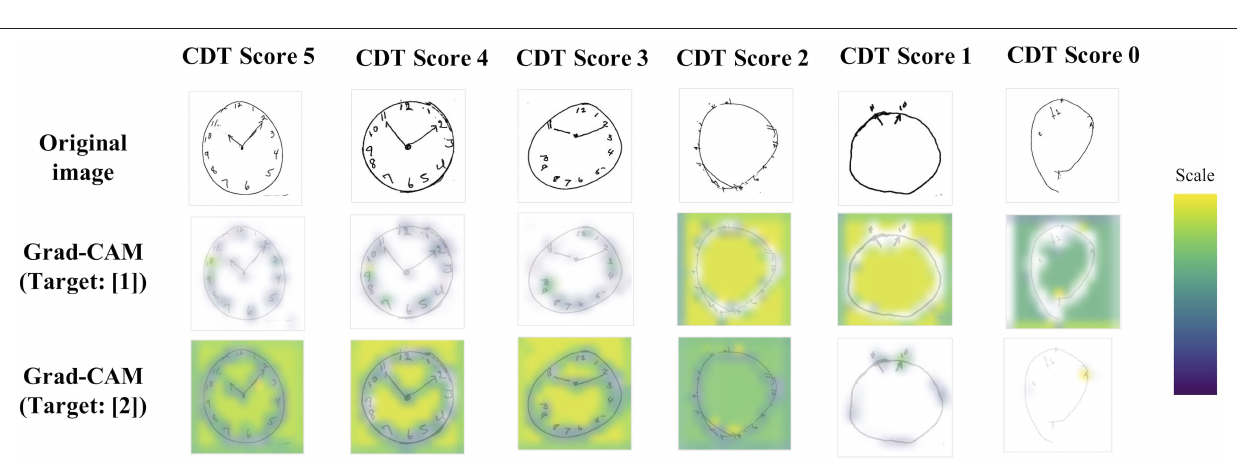
FIGURE 3 | Prediction performance. An example of the learning curve for predicting executive dysfunction. Serial change is observed in loss function (A) and accuracy (B) as learning goes. Predictive performance is summarized in terms of accuracy (C) , balanced accuracy (D) , PLH (E) , and NLH (F) for each of the target variables (i.e., “executive dysfunction” or “probable dementia”). PLH, positive likelihood ratio; NLH, negative likelihood ratio.